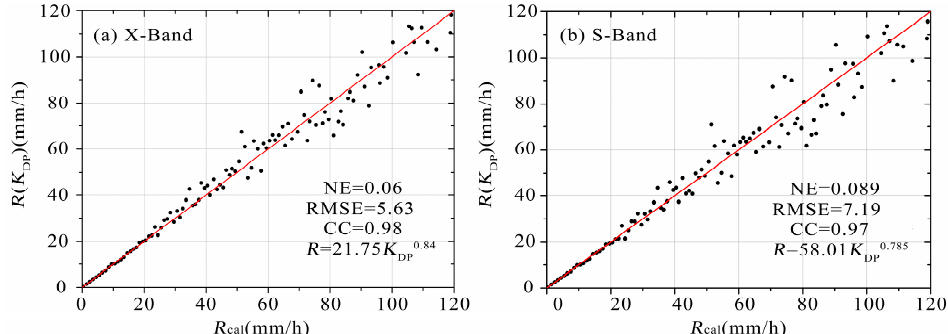
Figure 3. A comparison between the R ( K DP ) and the intrinsic rainfall rate R cal directly observed by the 2DVD for X-band ( a ) and S-band ( b